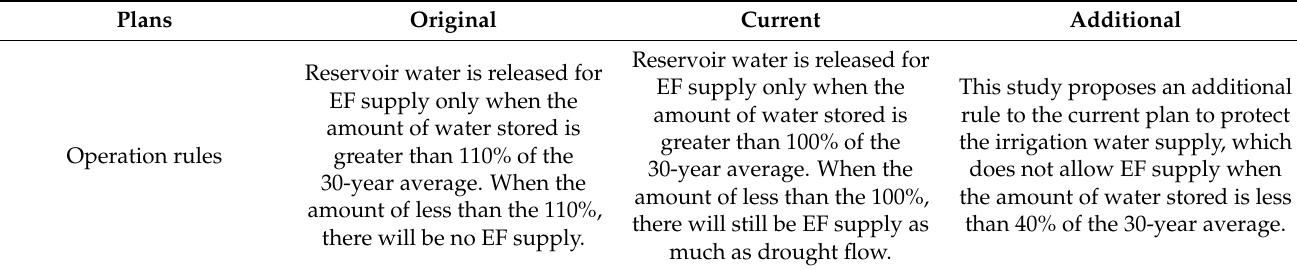
Table 2. Comparison of the original, current, and additional reservoir operation rules for EF and irrigation water supply. Plans Original Current Additional